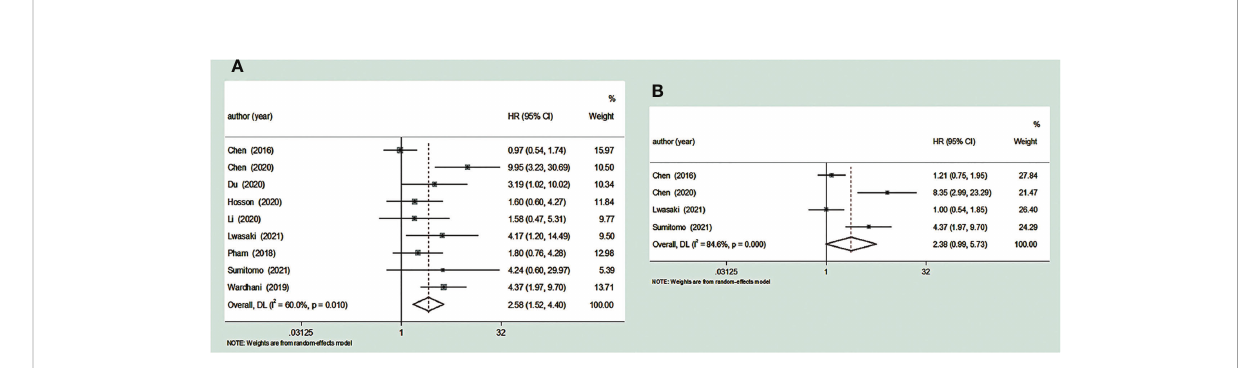
FIGURE 3 Forest plot for the relationship between TDO2 expression and OS/PFS. (A) The correlation between TDO2 expression and OS in human tumors. (B) The correlation between TDO2 expression and PFS in human tumors. HR, hazard ratio; 95% CI, 95% con fi dence interval; OS, overall survival; PFS, progression-free survival; TDO2, tryptophan